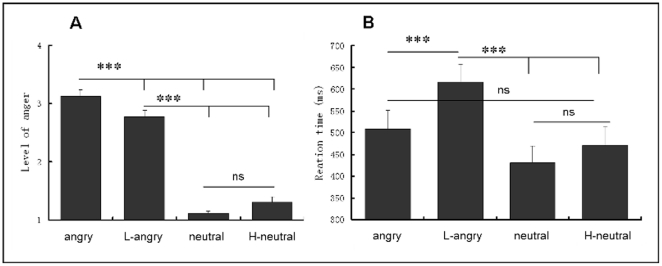
Rating scores (A) and reaction times (B) for four types of prosodies in Experiment 1 (M±se).In this figure, as in the following ones, Asterisk (*) indicates a significant response difference at P<0.05, ** at P<0.01, and ** * at P<0.001.